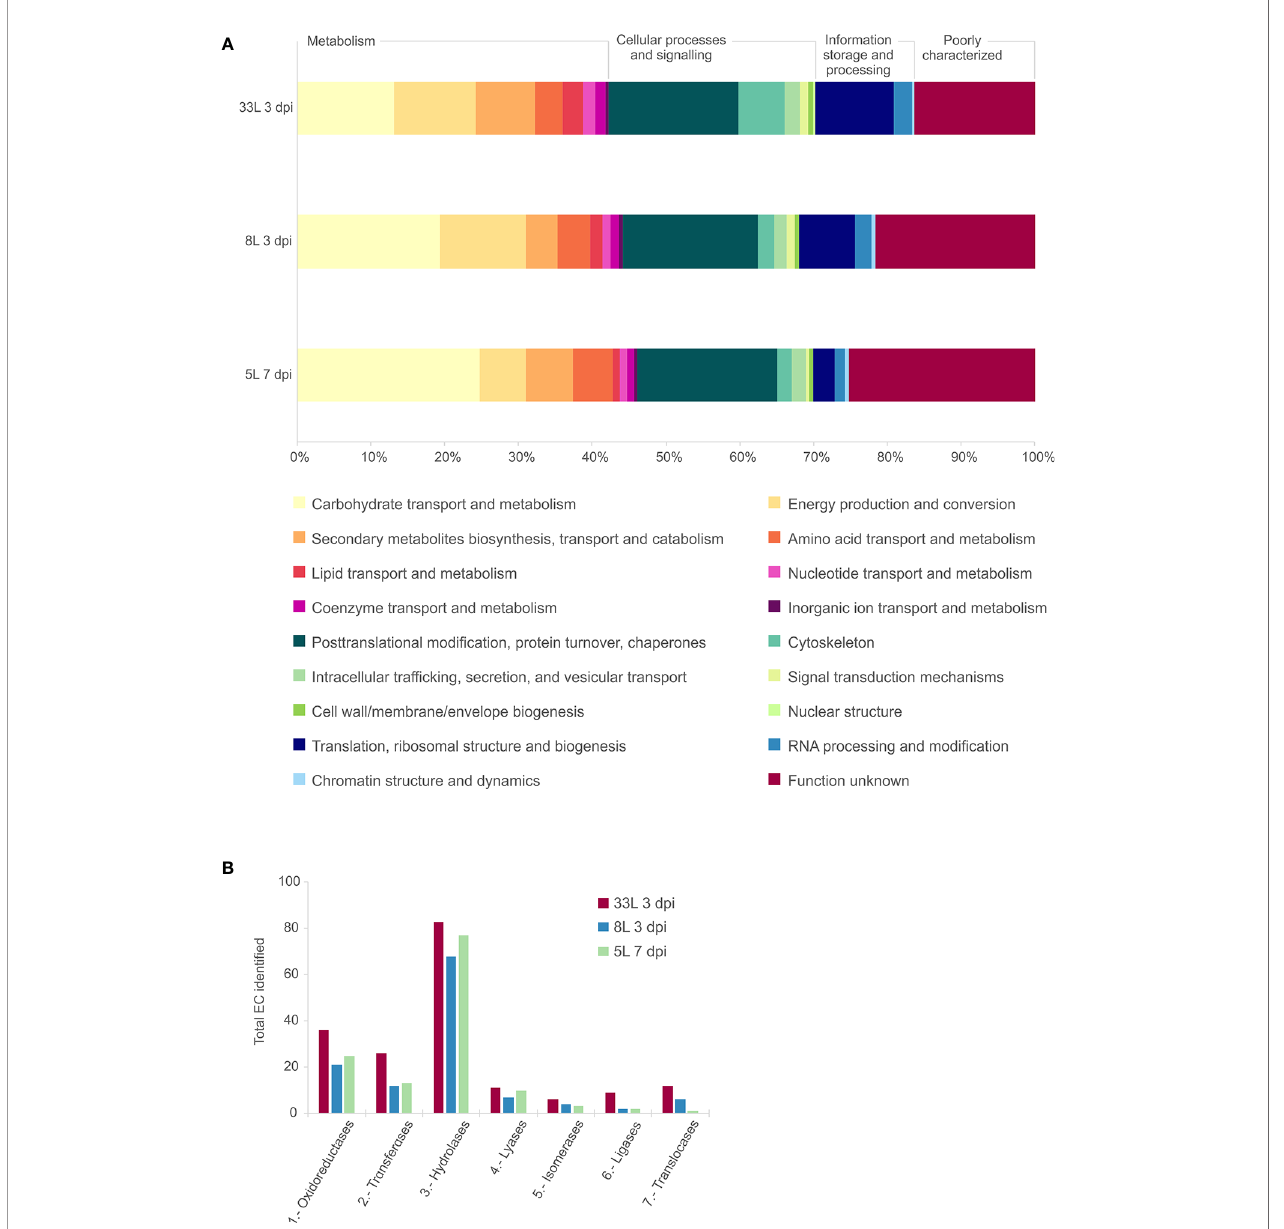
FIGURE 2 | Comparative analysis of the identi fi ed proteins in exoproteome of M. laxa isolates for 3 days post-inoculation (dpi) in 8L and 33L virulent isolates, and 7 dpi in 5L weak virulent. (A) Category abundance of identi fi ed proteins in exoproteome grouped into 18 functional categories using OG classi fi cation for 5L, 8L and 33L M. laxa isolates. (B) Enzyme distribution of identi fi ed proteins for M. laxa isolates represented as total number of proteins identi fi ed in each EC